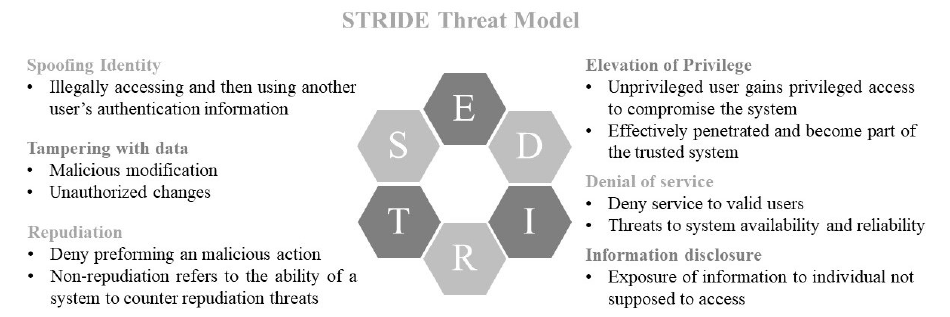
Figure 1. Representation of STRIDE Threat Model.